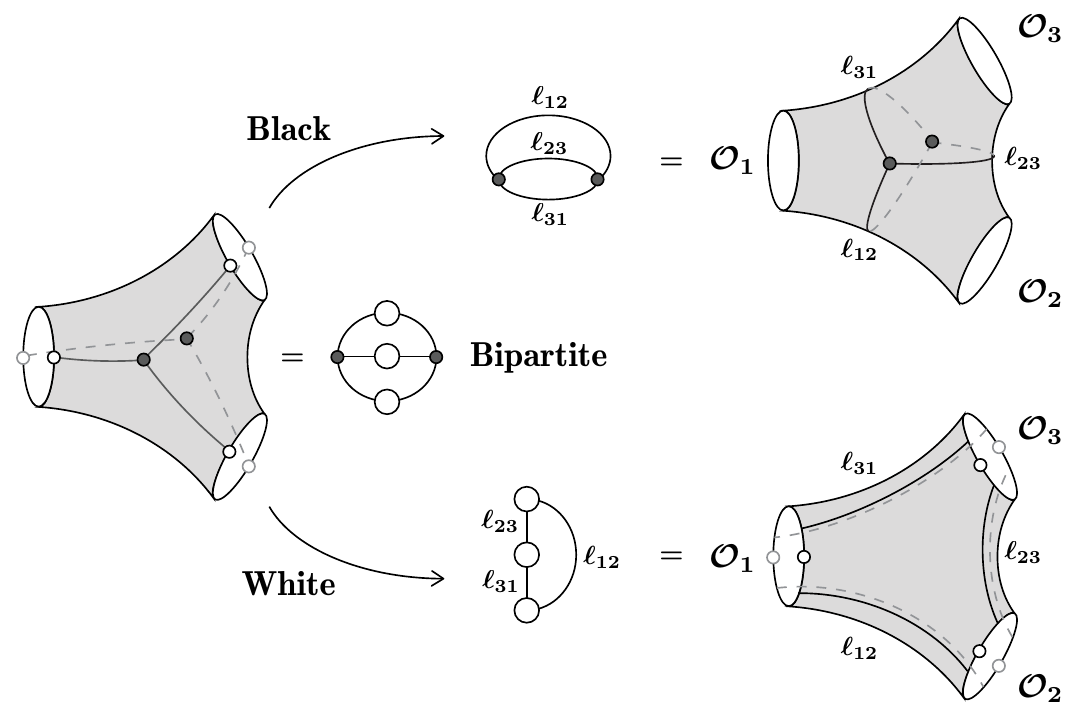
Figure 29 . Three types of the connected ribbon graph with ( g; n ) = (0 ; 3); bipartite, black and white. The black and white graphs are dual to each